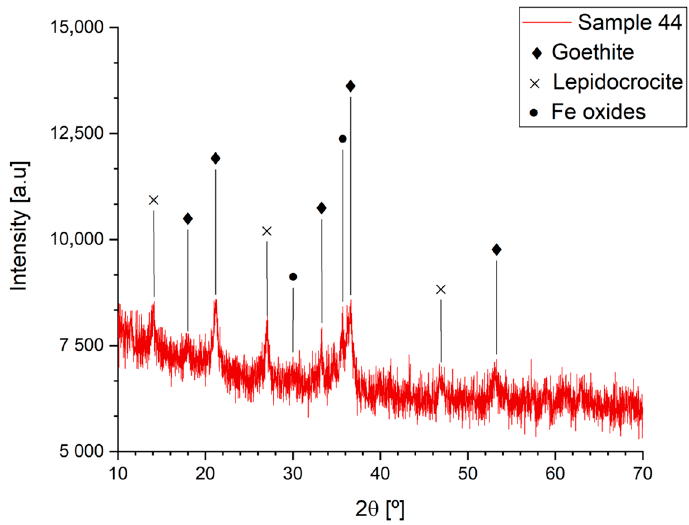
Figure 9. XRD analysis of sample 44.